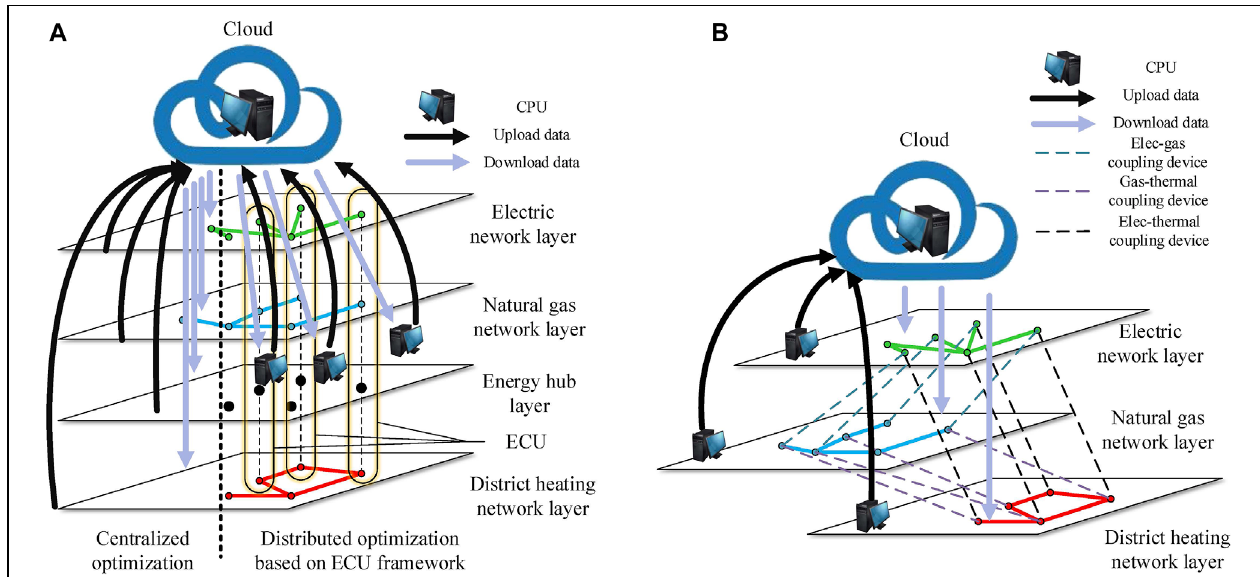
FIGURE 2 | Data flow of different optimization methods in IES. (A) Data flow of the centralized optimization and the ECU architecture distributed optimization. (B) Data flow of the distributed optimization decoupled according to energy networks.